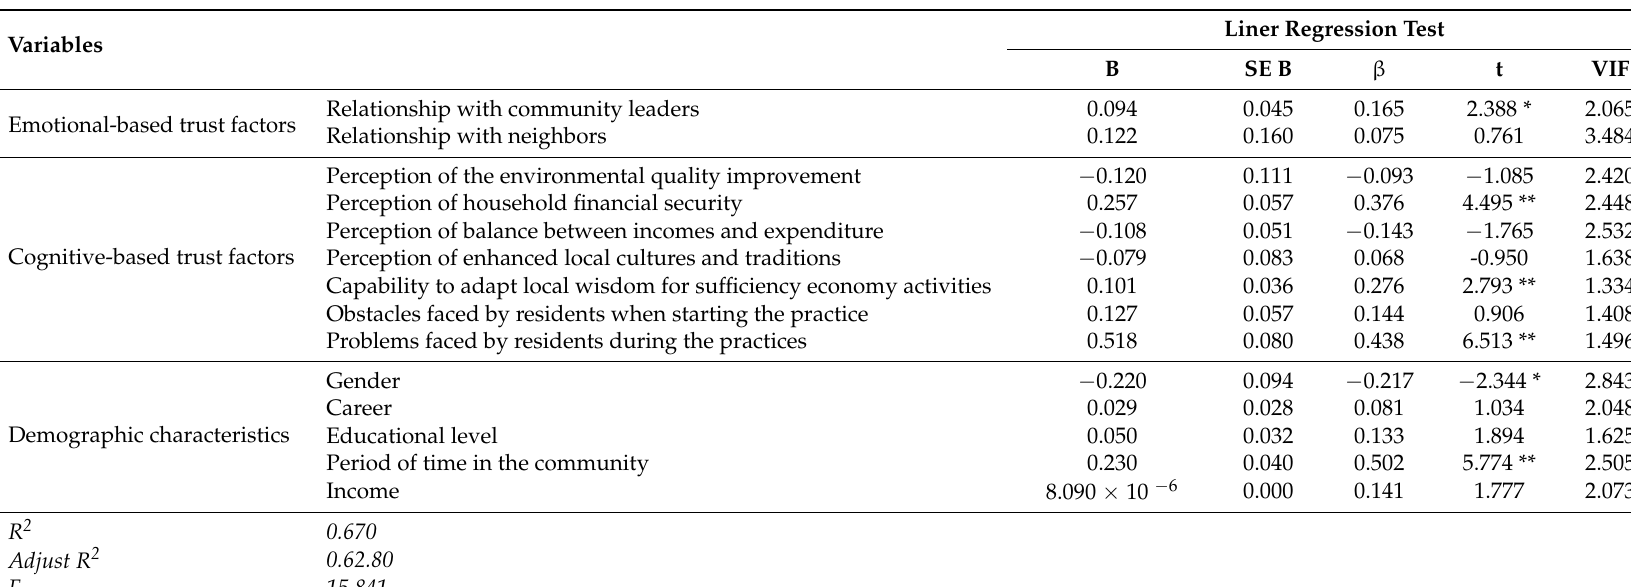
Table 5. Summary of regression analysis for variables predicting community